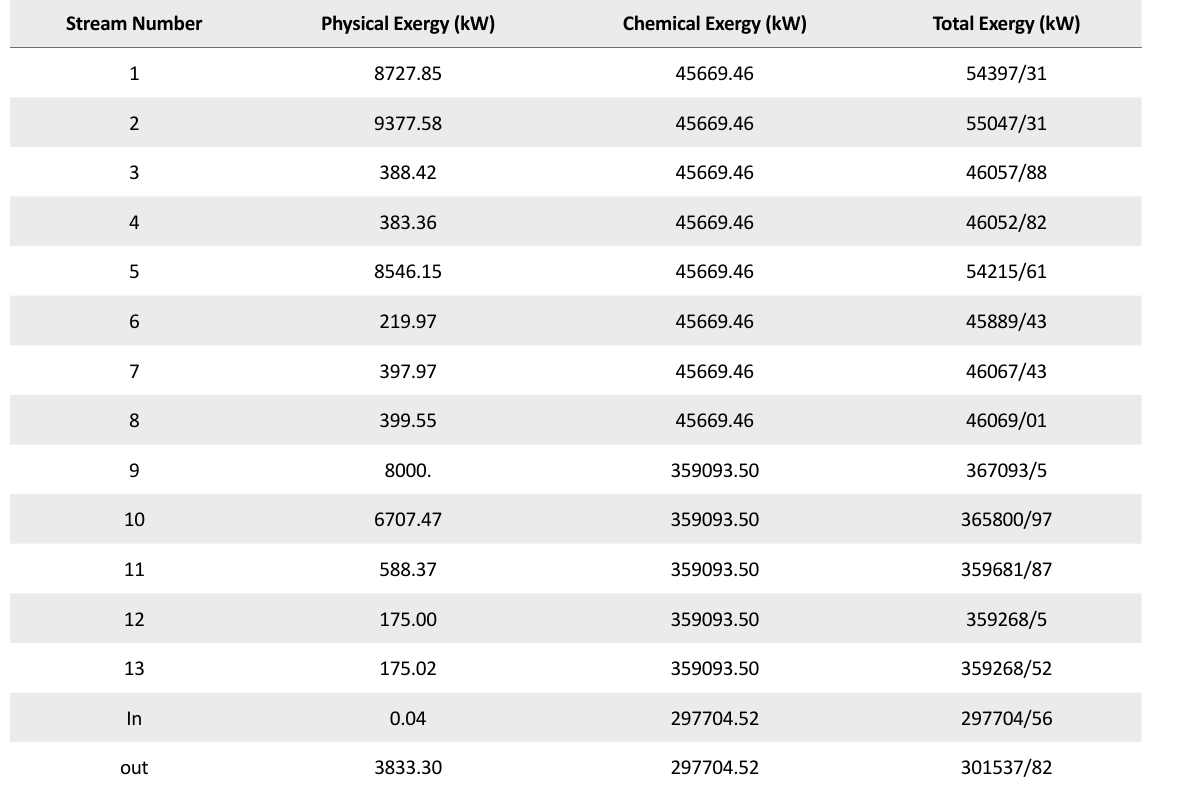
Table 2. Results of exergy currents Stream